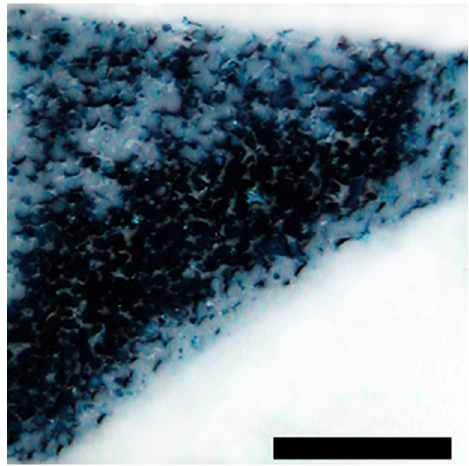
Figure 4. Illustration of pore interconnectivity in an Actifit ® scaffold. Black areas represent accessible pores whereas white areas signify secluded pores. A major part of the scaffold’s area is shows a black color, thus proving good pore interconnectivity Magnification bar = 1 mm.